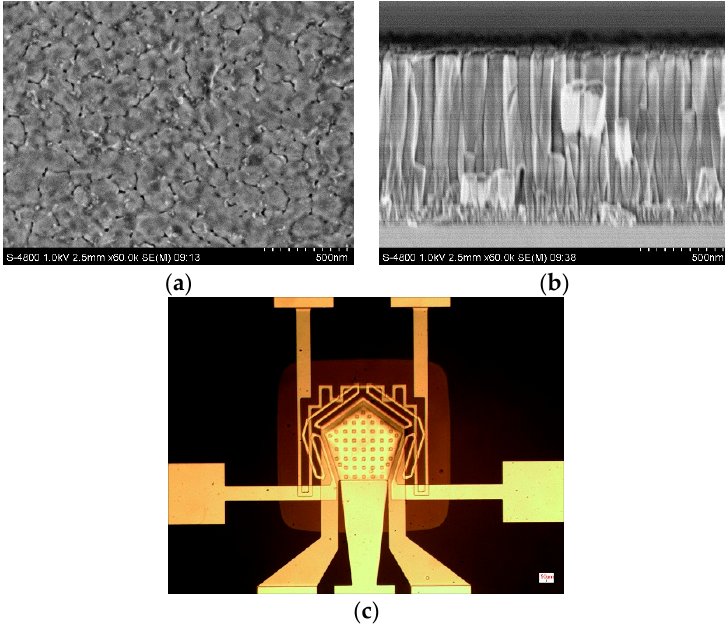
Figure 4. Scanning electron microscope (SEM) photos of the ZnO film: ( a ) top view; ( b ) cross-section; ( c ) the microscopic photo of the fabricated FBAR chip.